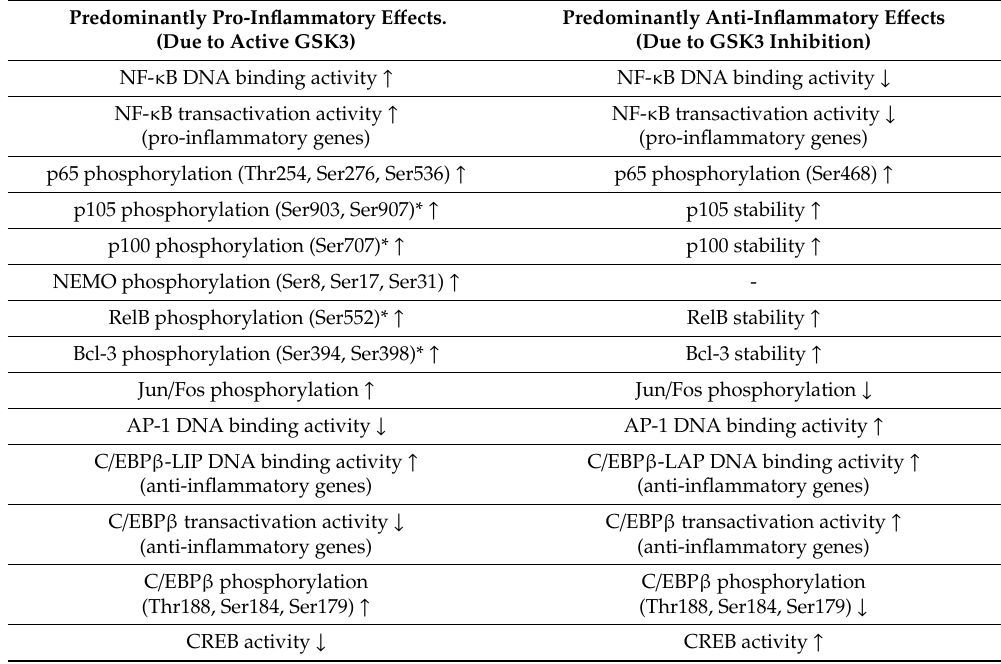
Table 1. Molecular events regulated by GSK3 that mediate pro- or anti-inflammatory e ff ects. Predominantly Pro-Inflammatory E ff